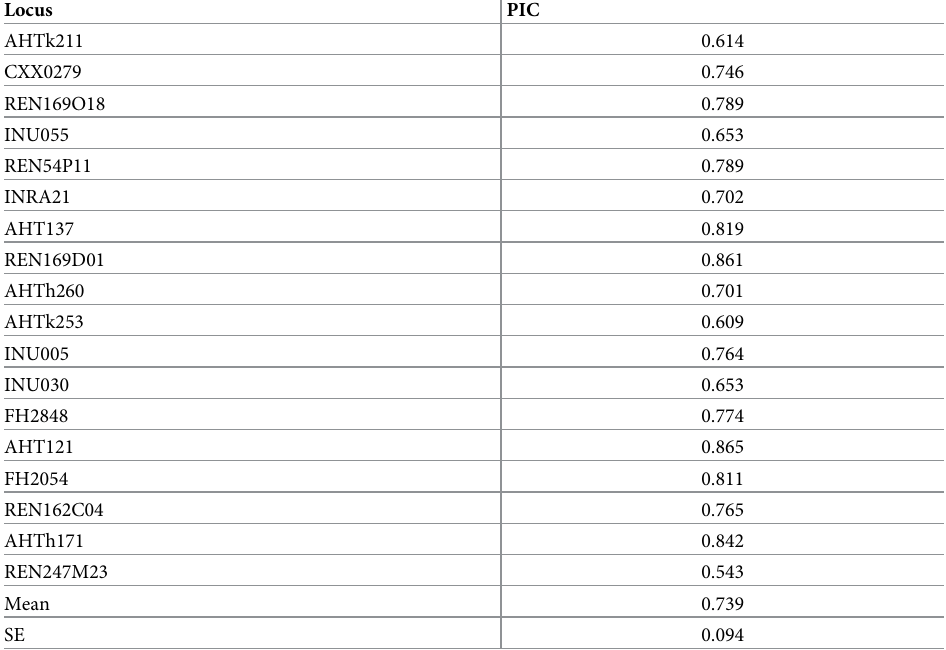
Table 2. PIC of 18 STR markers of the Tazy. Locus